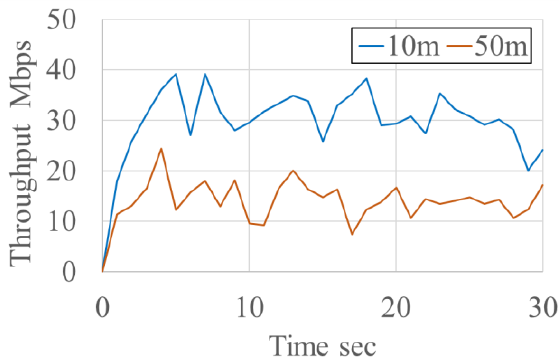
Figure 9. Temporal evolution of TCP throughput in each communication distance (the sender is PC): The blue line is the 10 m results, and the orange line is the 50 m results.